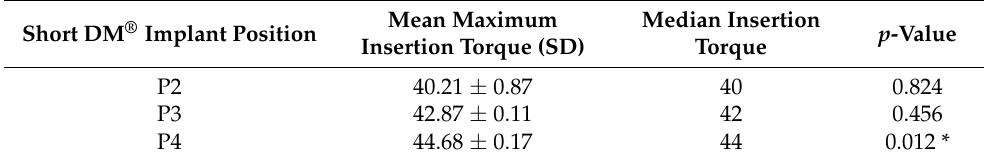
Table 1. Maximum insertion torque and median insertion torque of extra-short wide and narrow ring implants. SD—standard